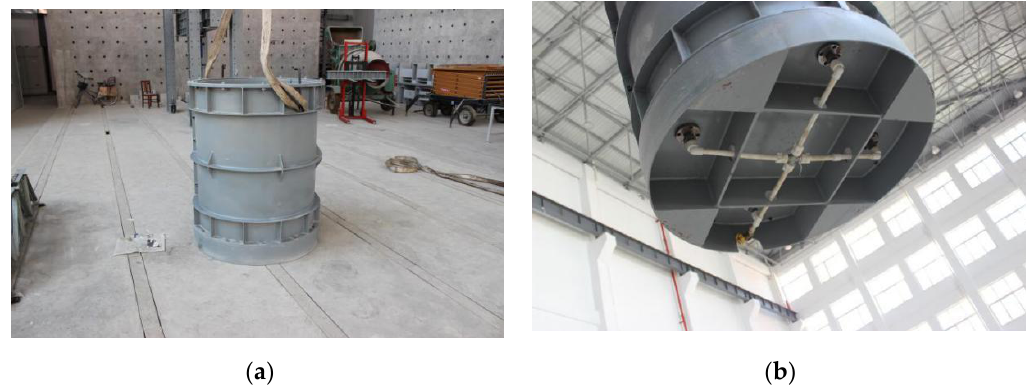
Figure 5. Model box: ( a ) physical drawing of model box; and ( b ) model box drainage system. A load cell (of 100 kN capacity) was fitted on the top of the test pile. Above the load cell lied a plunger